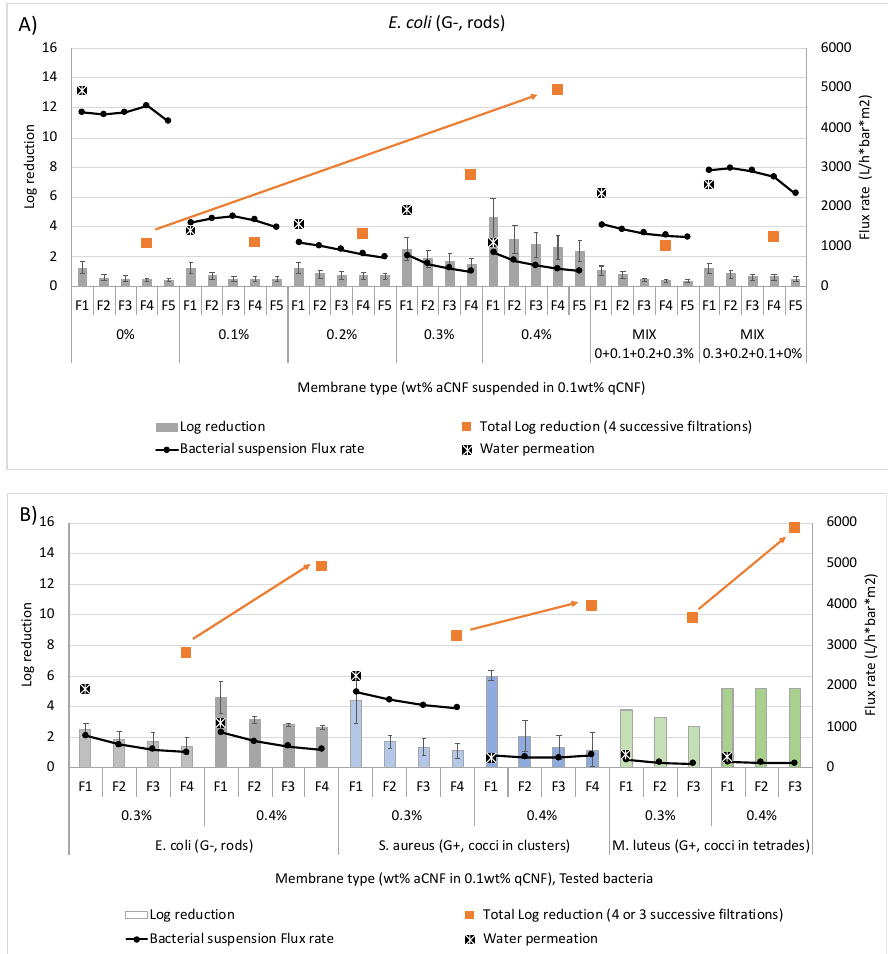
Figure 6. The effect of differently prepared (impregnated with different wt% of amino-hydrophobised CNF/aCNF, pre-suspended in 0.1 wt% quaternised cellulose nanofibrils/qCNF) individual (single-layered) membrane on permeation of (300 mL) deionised water and flux rate of bacterial suspension with log reduction values for ( A ) rod-shaped ( G− ) Escherichia coli (EXB-V127) vs. ( B ) round-shaped (G+) Staphylococcus aureus (EXB-V54) and (G+) Micrococcus luteus (EXB-V52), per- formed with vacuum filtration at a pressure of 0.6 bar. Apart from the membrane porosity, bacterial cells may be prevented from passing through the membrane due to electrostatic and (even stronger) hydrophobic interactions with the membrane material, as well as the physicochemical properties of both the mem- brane and the bacterial cells [2]. As shown in Figure S2, which presents the morphology of Gram-stained stationary-phase bacterial cells of the test strains, the size, shape and ar- rangement of bacterial cells differed significantly: E. coli (EXB-V127) is characterised by single rod-shaped cells with rounded ends (bacilli; 0.5 –1 μm in diameter and 2–5 μm in length), whereas the cells of the other two bacteria are spherical (cocci) and tend to be arranged in groups of different sizes. Namely, S. aureus (EXB-V54; 0.5 –1 μm in diameter)